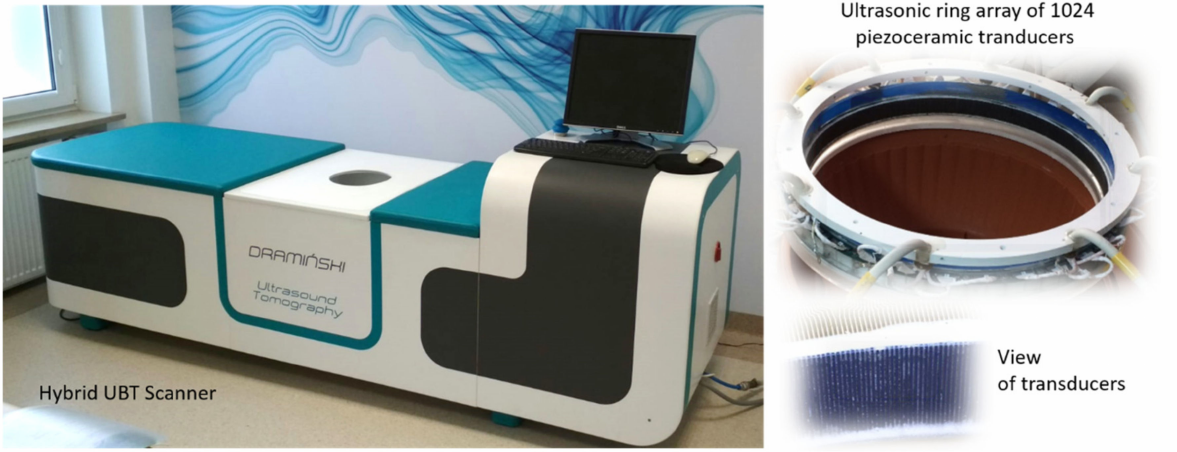
Figure 7. View of the prototype of the hybrid UBT scanner developed by DRAMI ´NSKI S.A., the ultrasonic ring array, and elementary